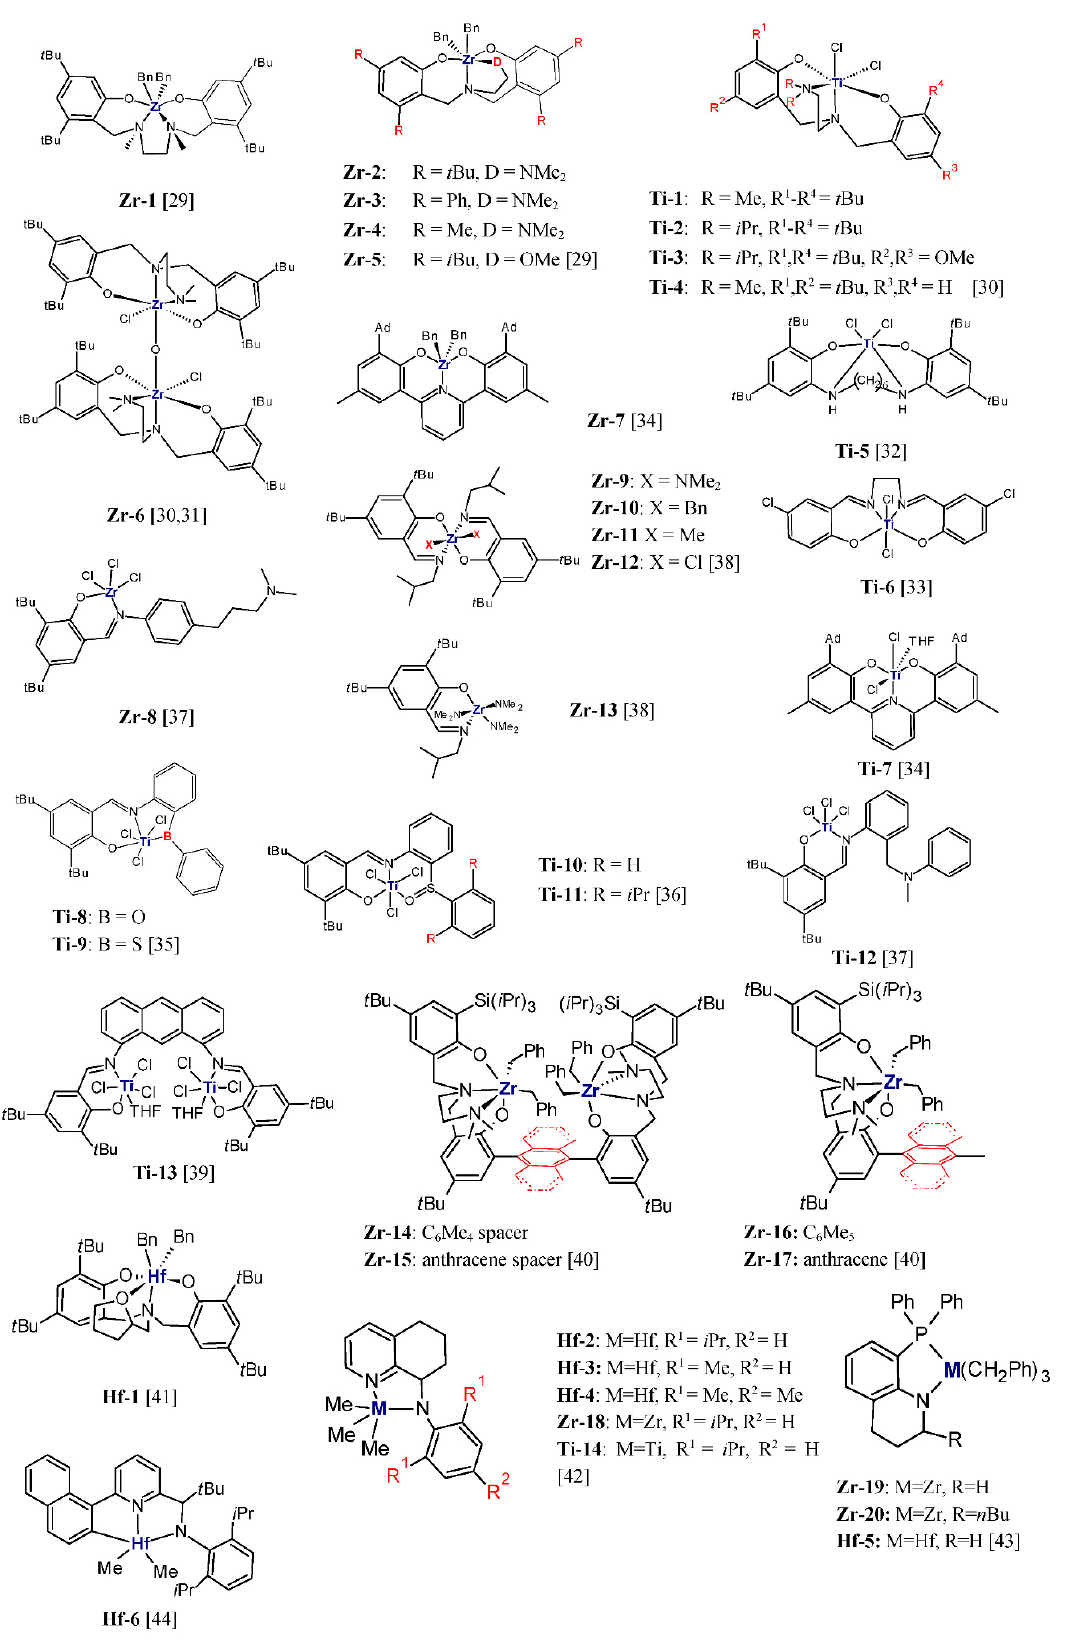
Figure 1. Titanium, zirconium and hafnium complexes investigated as precatalysts for ethylene/1-olefin copolymerization [29–44].